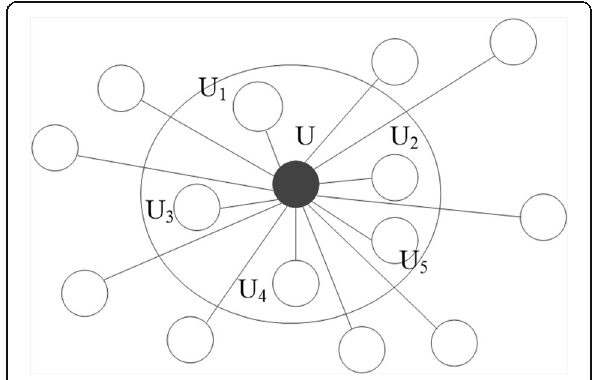
Fig. 3 The formation of user nearest